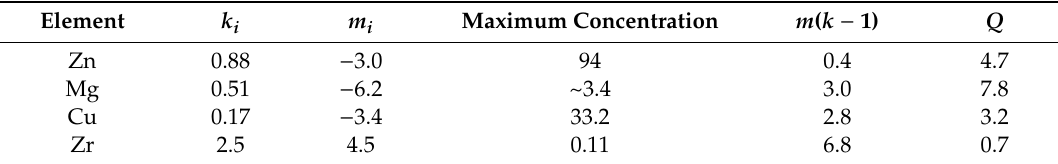
Element k i m i Maximum Concentration m ( k − 1) Zn